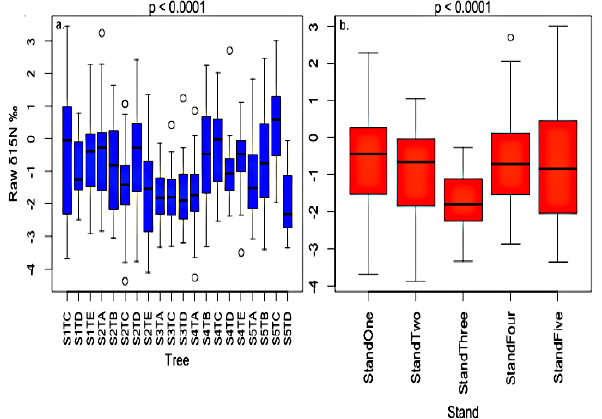
Figure 4. Box plots showing differences in means between trees (a) and stands (b) . (a) Box plot of δ 15 N for each tree. S refers to the stand (i.e., S1: stand 1), and T refers to tree (T1: tree 1). (b) Same as Fig. 4a but for the five stands analyzed. The box plots are based on the averages from each stand. Data averaged over the time